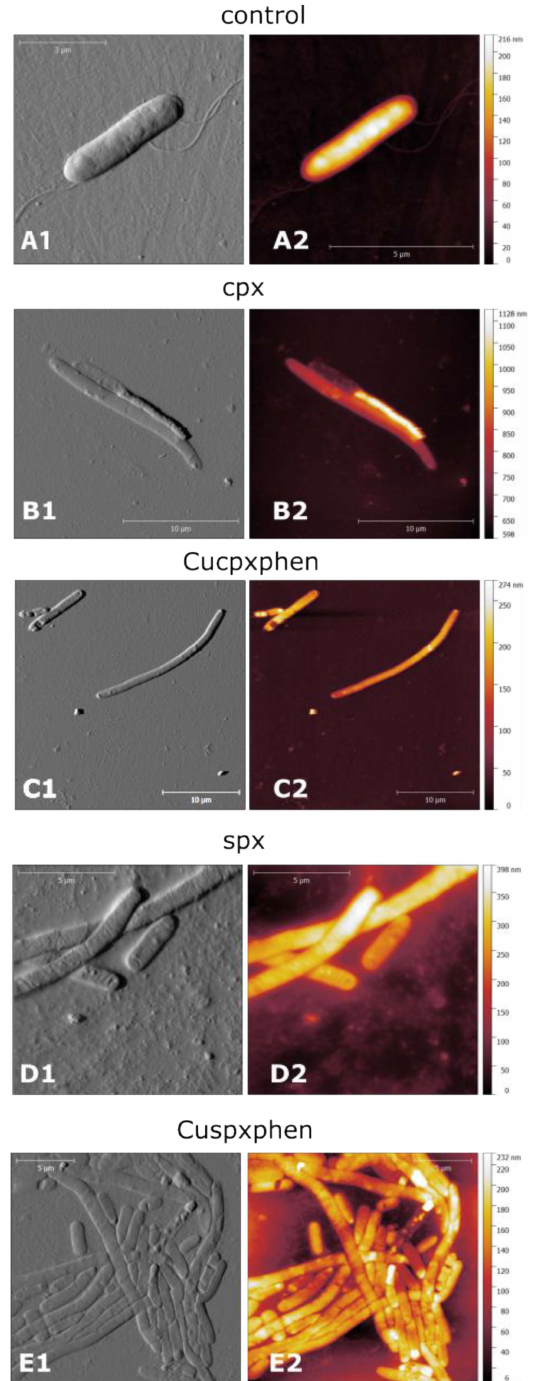
Figure 3. AFM images of E. coli ATCC 25922–control cells ( A ) and cells treated with cpx ( B ), Cucpxphen ( C ), spx ( D ) and Cuspxphen ( E ). A1, B1, C1, D1 and E1 are amplitude images; A2, B2, C2, D2 and E2 are height images. These images are representative of the multiple areas from at least three samples analyzed for each condition